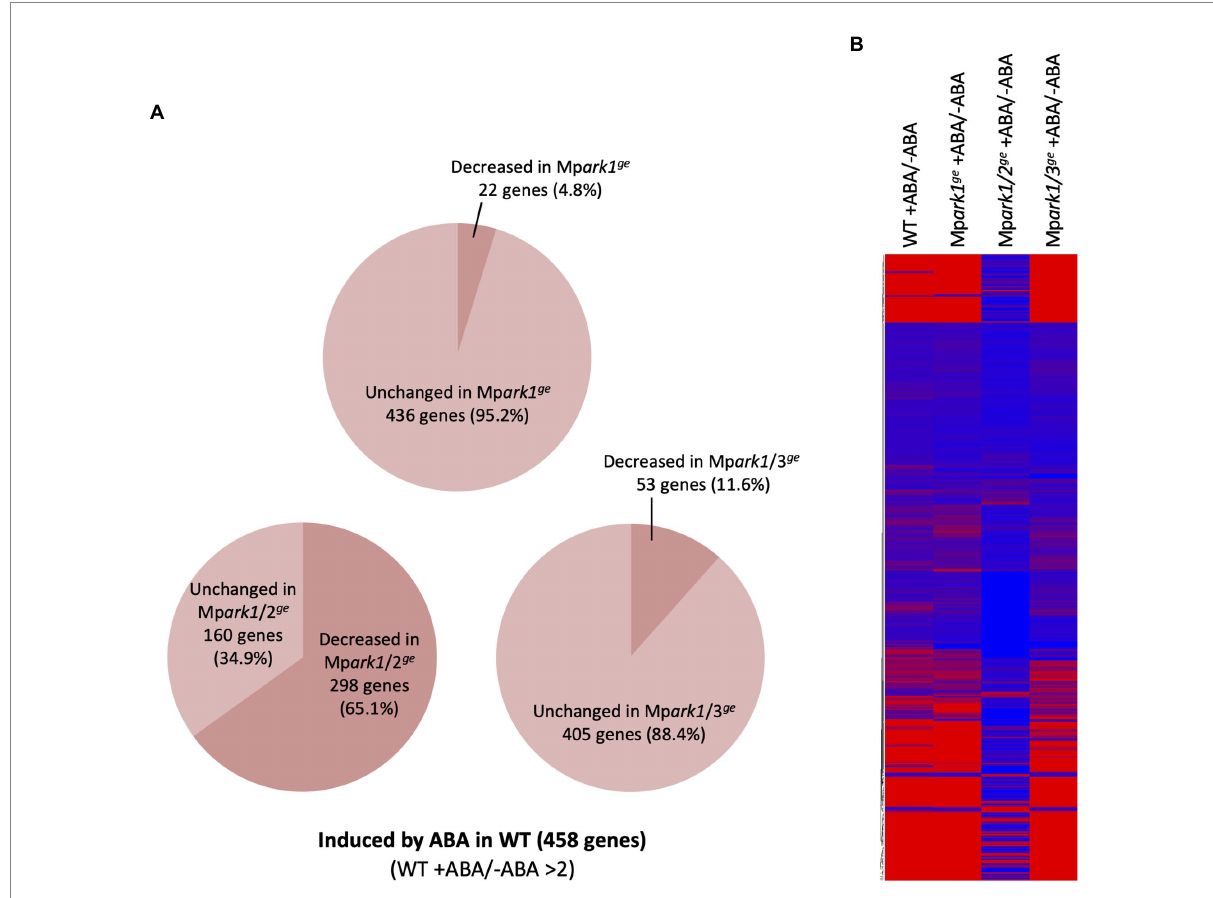
FIGURE 5 Profiles of ABA-responsive gene expression in wild type (WT) and the B3-Raf genome-editing lines. (A) Percentages of ABA-induced genes (>2) for which expression was reduced (<2) in the genome-editing lines. (B) Heat map showing ABA-induced and ABA-reduced genes in WT and the genome editing lines. The fold change used for the color key was calculated by comparing values of ABA-treated and control